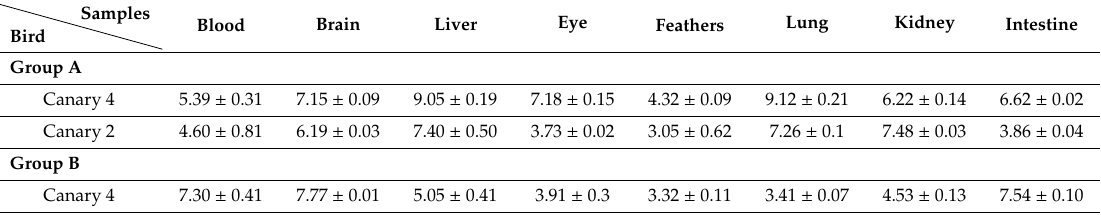
Table 2. USUV RNA loads in domestic canaries which succumbed to the experimental infection with USUV as determined by RT-qPCR and expressed in log10 viral RNA